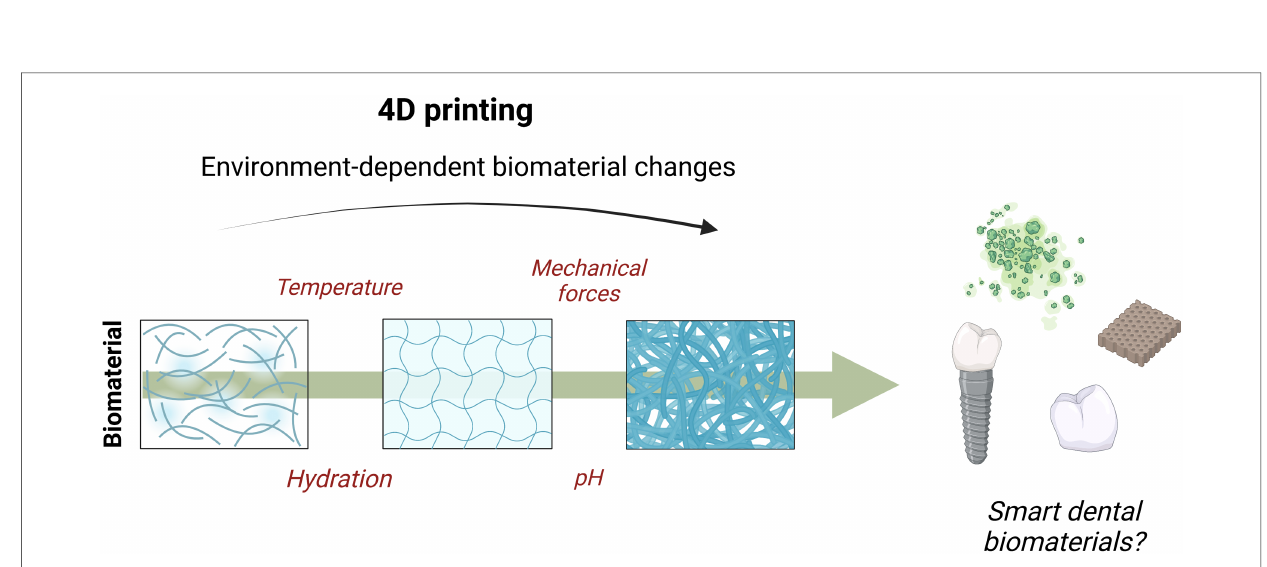
FIGURE 3 Summary of lab-on-a-chip approaches currently being explored for pre-clinical and clinical applications in dentistry. Micro fl uidics-based lab-on-a-chip systems are expected to serve as low-cost diagnostic platforms for saliva and blood screening against cells and biomarkers of interest. Furthermore, these microchips have shown great potential for the easy and cost-effective pre-clinical evaluation of the cytotoxic and antibacterial properties of novel dental